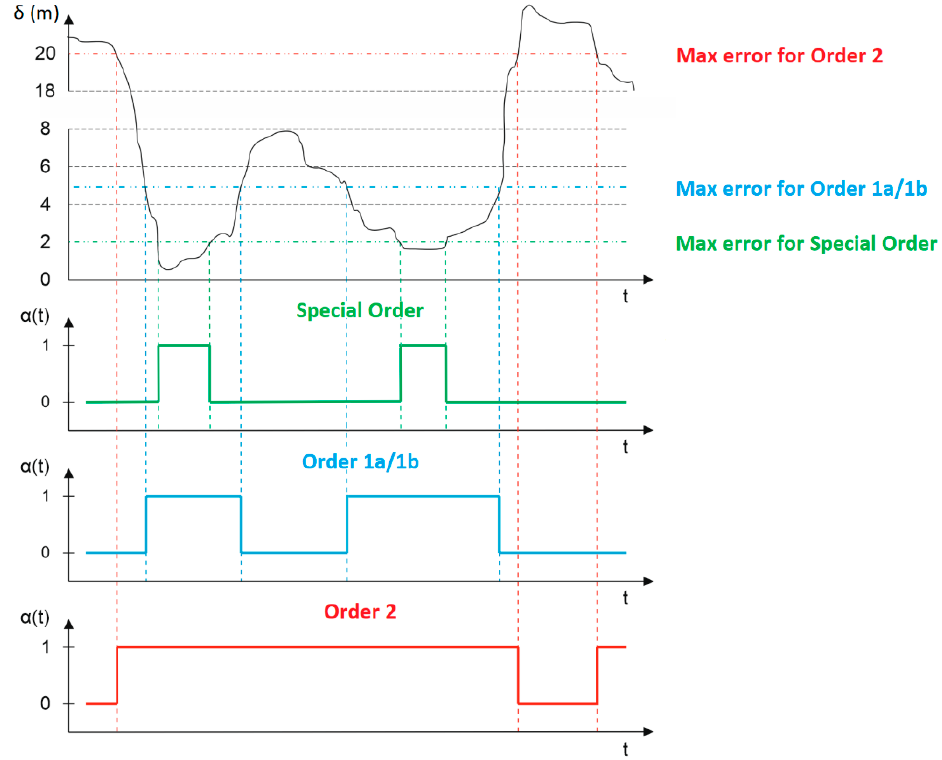
Figure 7. The position error as a function of time (the upper diagram) and three diagrams corre- sponding to the operational status for the following IHO orders: Special (green colour), 1a/1b (blue colour) and 2 (red colour) [81].